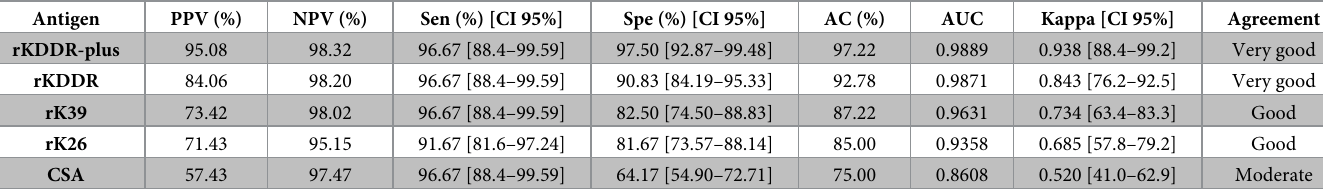
Table 2. Diagnostic performance of ELISA tests to detect antibodies against canine visceral leishmaniasis (CVL).